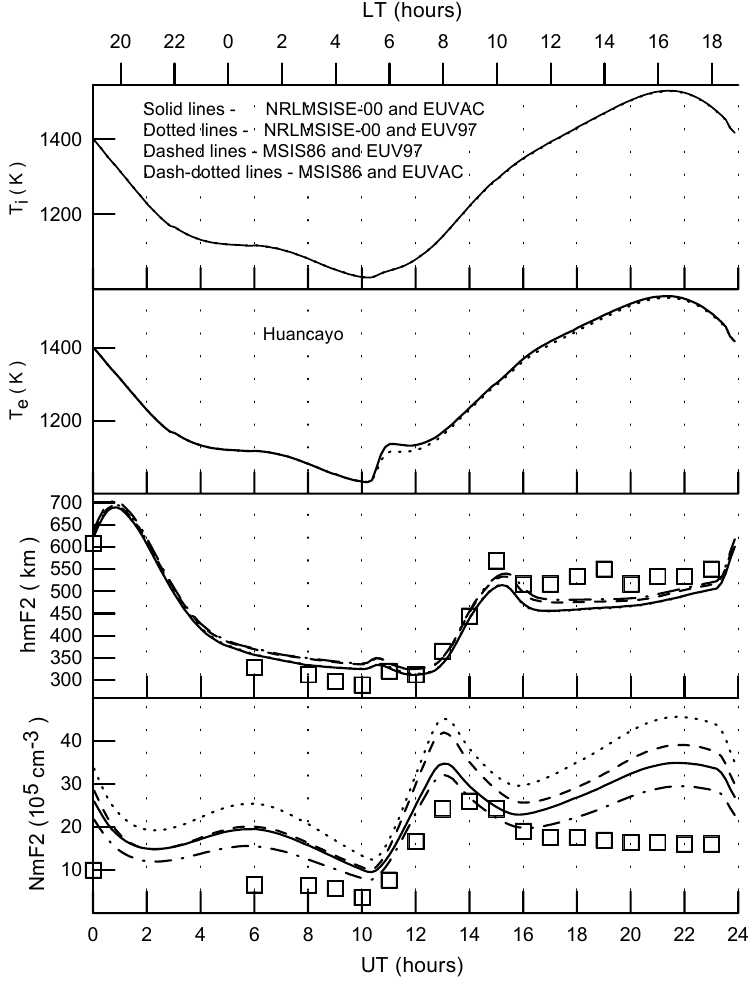
Fig. 3. Observed (squares) and cal- culated (lines) Nm F2 and hm F2 (two lower panels), and electron and O + ion temperatures (two upper panels) at the F2-region main peak altitude above the Huancayo ionosonde station on 7 Oc- tober 1957. The results obtained from the model of the ionosphere and plas- masphere using the combinations of the original NRLMSISE-00 or original MSIS-86 neutral temperature and den- sities model and the EUVAC or EUV97 solar flux models as the input model pa- rameters are shown by solid lines (the NRLMSISE-00 model in combination with the EUVAC model), dotted lines (the NRLMSISE-00 model in combi- nation with the EUV97 model), dash- dotted lines (the MSIS-86 model in combination with the EUVAC model), dashed lines (the MSIS-86 model in combination with the EUV97 model). LT is the local time at the Huancayo ionosonde